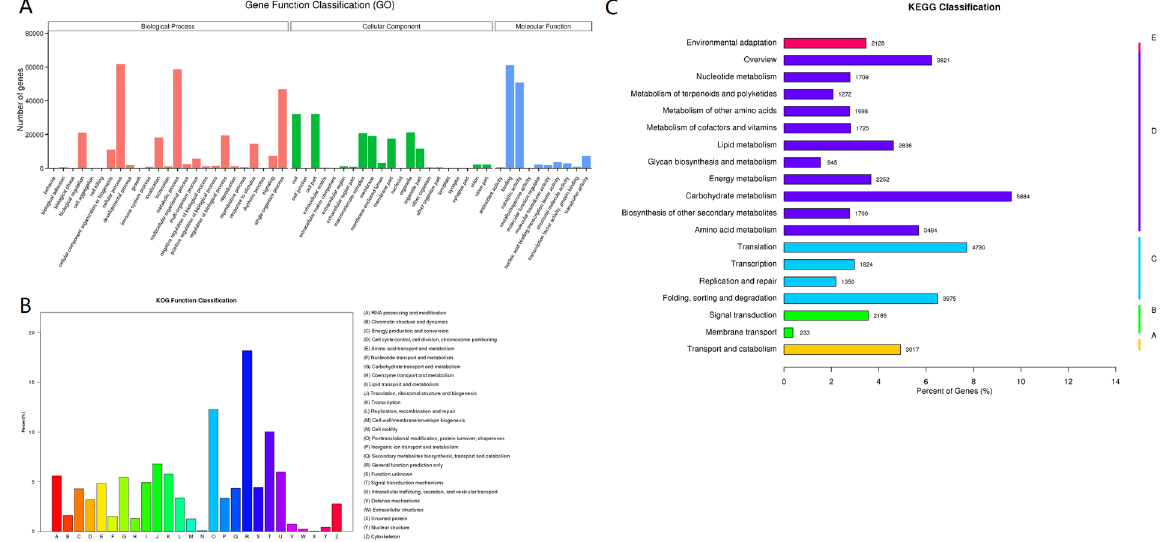
Figure 1. Functional annotation and classfication of S. cannabina transcriptome. ( A ) GO categorization of non-redundant unigenes. Each annotated sequence was assigned at least one GO term. ( B ) COG annotation of putative proteins. ( C ) KEGG annotation of putative proteins. The capital letters against the colored bars indicate five main categories, ( A ) cellular processes; ( B ) environmental information processing; ( C ) genetic information processing; ( D ) metabolism; and ( E ) organism